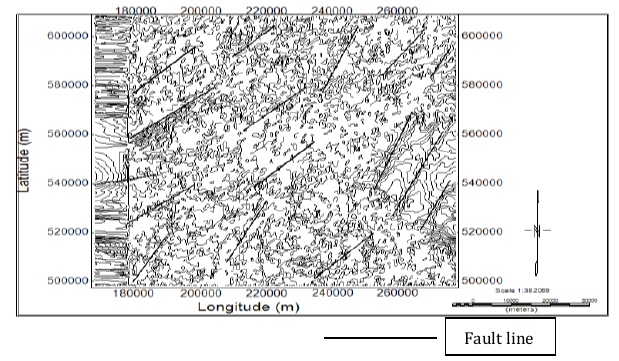
Figure 6: Magnetic lineament map showing the lines of the faults in the study area.